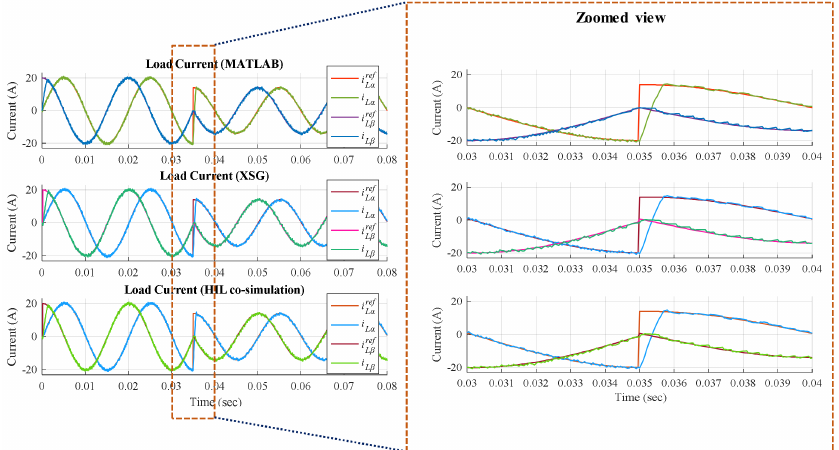
Figure 17. Current tracking for the real and imaginary components of the load current ( i L α and i L β ) obtained using MATLAB/Simulink, XSG, and HIL co-simulation for step change in